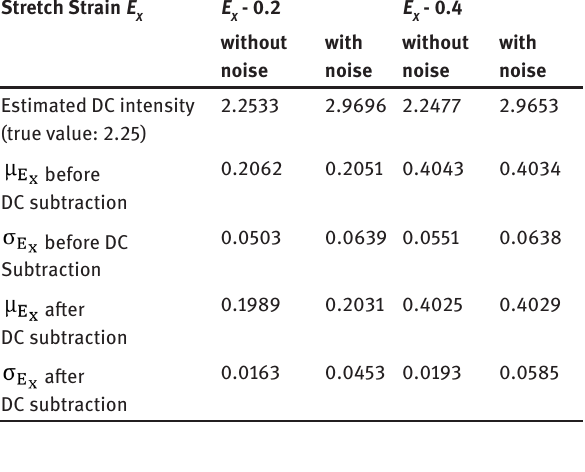
- 0.2, and (b) E - 0.4. X X